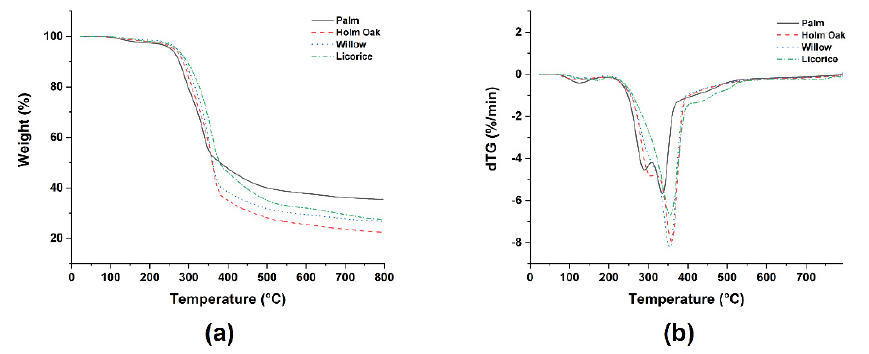
Figure 4. Thermal degradation behavior of lignocellulosic wastes: ( a ) weight loss vs. temperature and ( b ) derivative of weight loss vs. temperature.